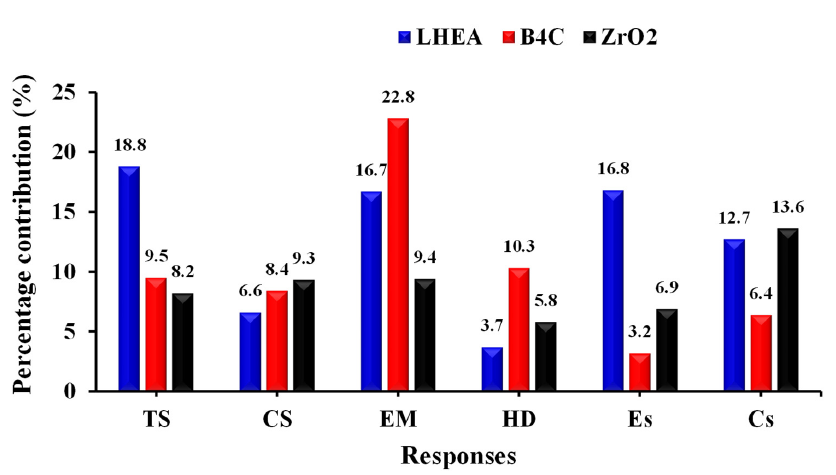
Figure 3. Percentage contribution of the input powders on response properties of the trihybrid ti- tanium composite . titanium